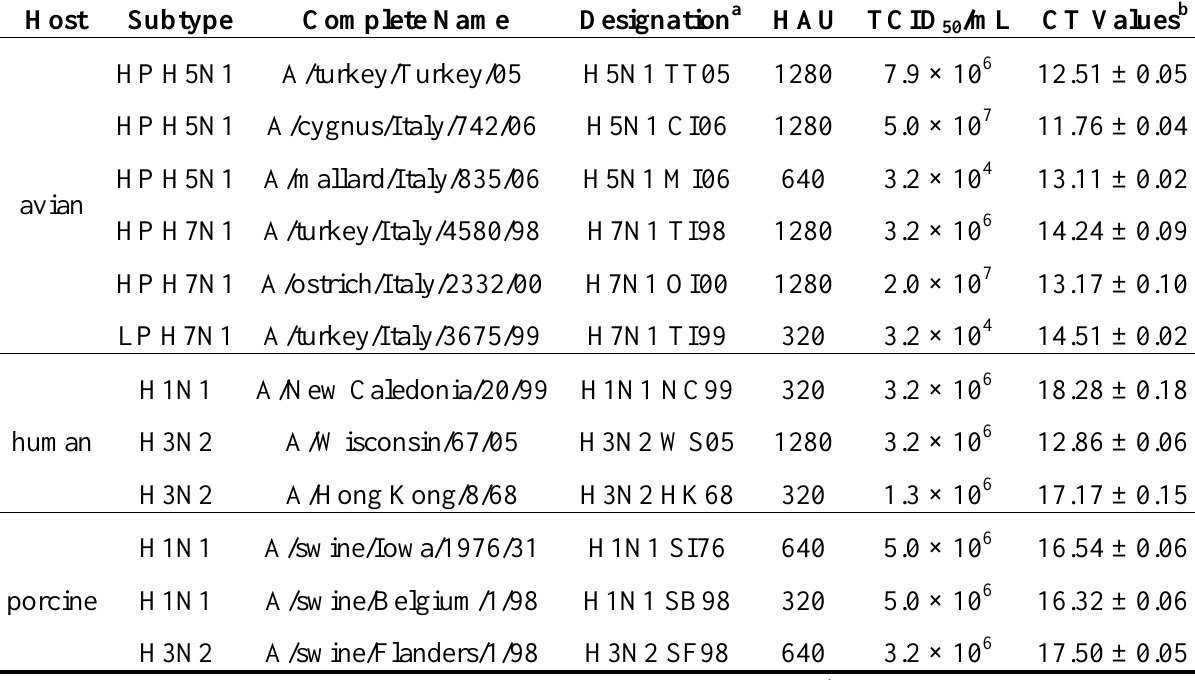
Table 1. List of influenza A virus (IAV) isolates used in this